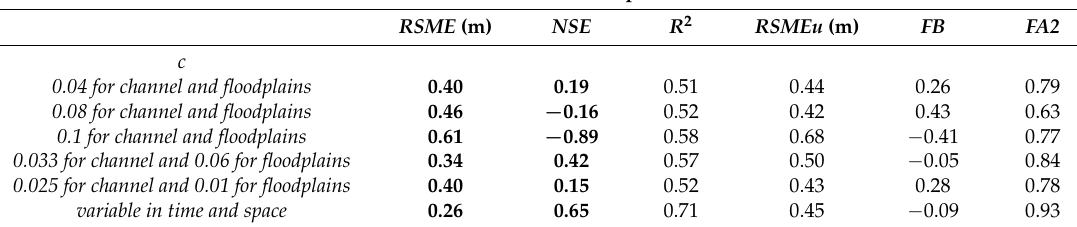
Table 8. Results of hydraulic simulation model calibration performance for 2 December 2013 in terms of water depth: the relative value of the Manning coefficients c , Root Mean Square Error RMSE , Nash- Sutcliffe Efficiency Coefficient ( NSE ), coefficient of determination R 2 , Unsystematic RSME RSMEu , fraction bias FB , prediction within a factor of two of observation FA2 .